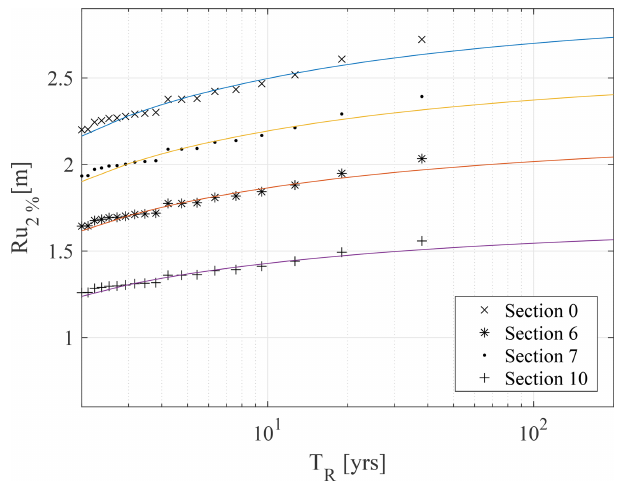
Figure 4. Return period curves for the run-up parameter; results are presented for just some of the cross-sections for the sake of